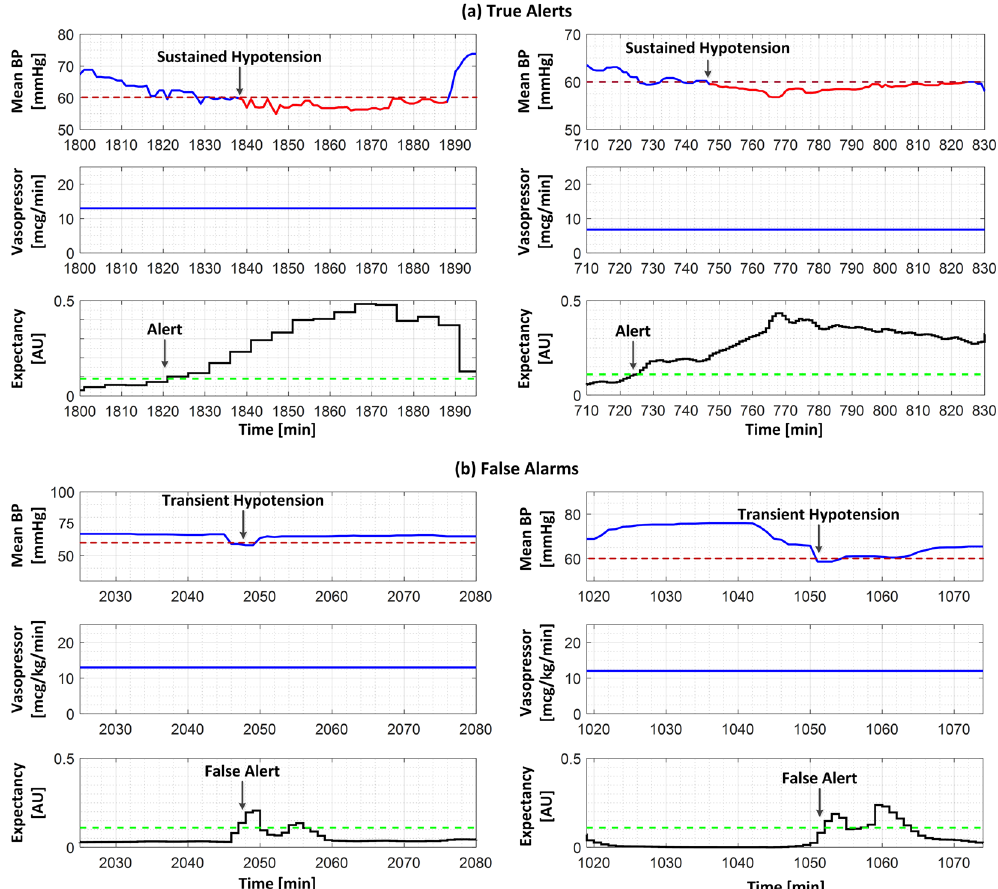
Figure 1. Examples of the investigational logistic regression model detecting sustained episode of hypotension (top panels) and triggering false alerts (bottom panels). At each time point, the logistic regression model used MAP measurements of the previous 60 min to compute an “expectancy” value that an episode of hypotension will be occurring within 15 min. Top panels: Two typical examples of successful prediction of sustained hypotension, in which sustained hypotension was preceded by steady decreases in the patient’s MAP, without any adjustments in vasopressor dose. In these examples, the model’s output value passed above the output threshold for alerting 17 (left) and 21 (right) minutes prior to the onset of the sustained episode of hypotension. Bottom panels: Two typical examples of false alerts occurring in the setting of transient hypotension that quickly resolved without any